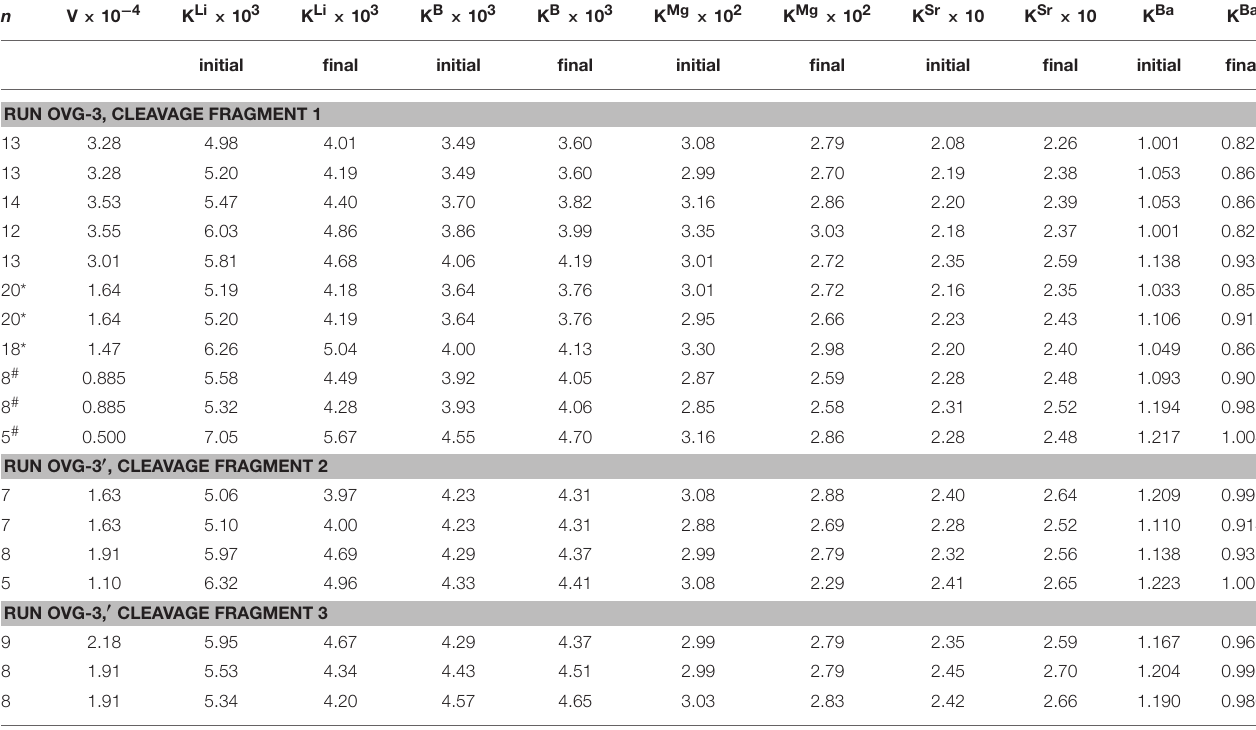
Frontiers in Earth Science |